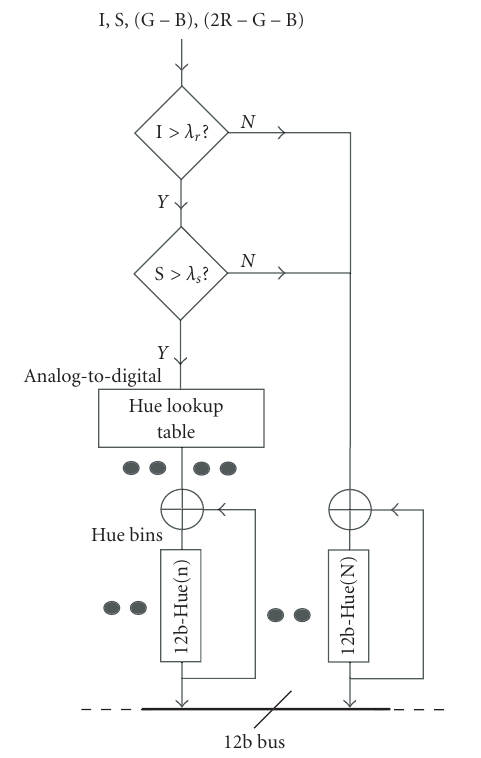
Figure 14: Block diagram of HSI histogramming.